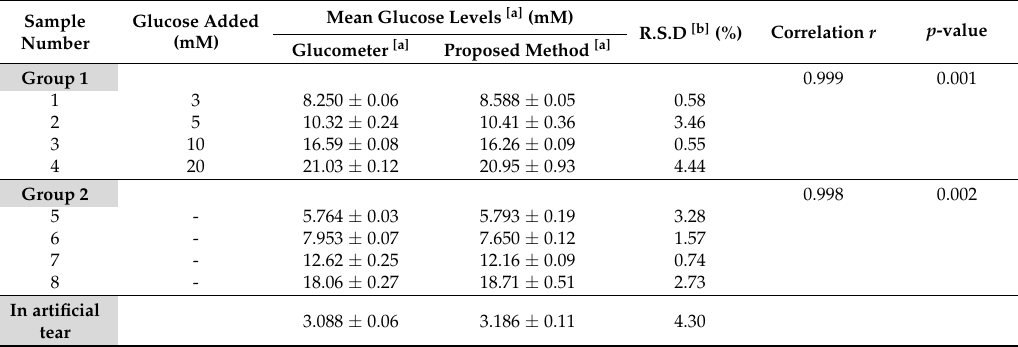
Table 2. Detection of glucose in human blood, artificial tear, and the association between various glucose values of the gel-encapsulated B5 and glucometer.